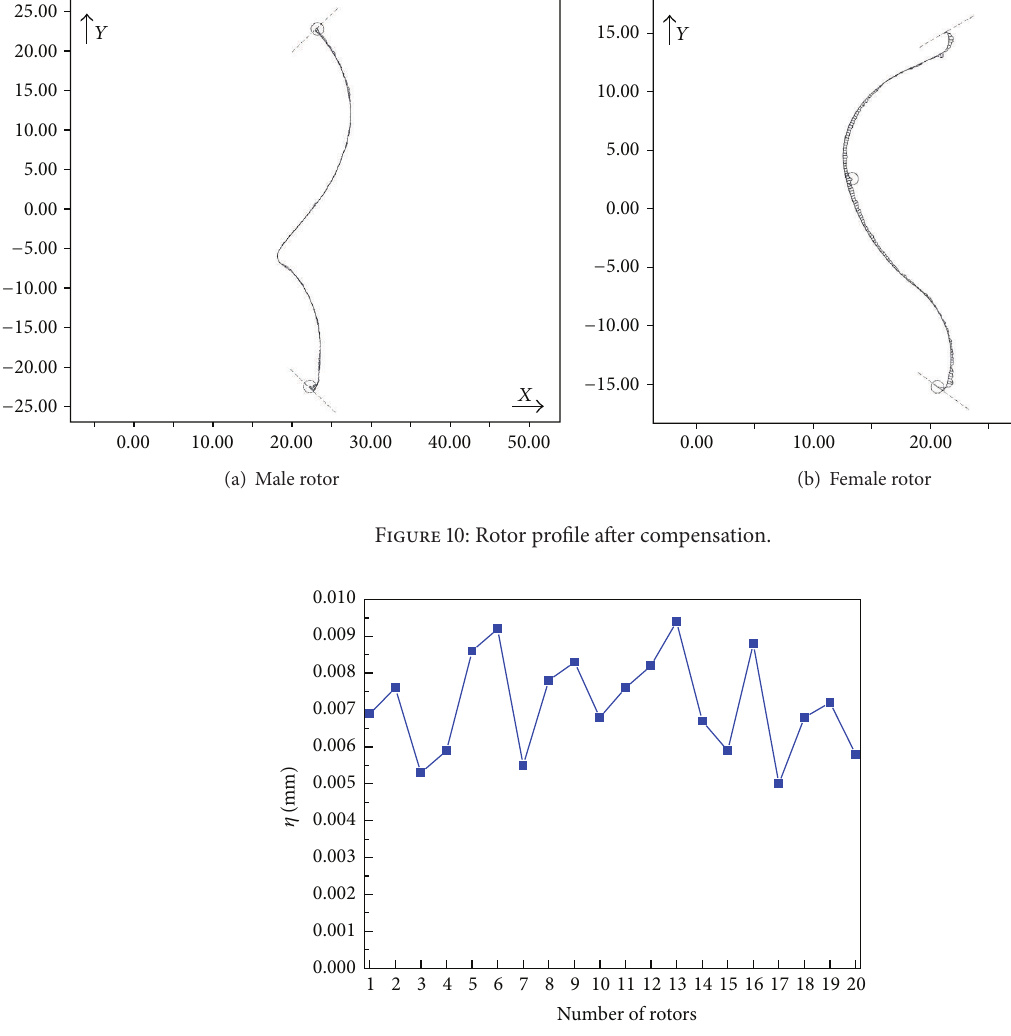
Figure 11: Overall errors of 20 consecutive machining rotor